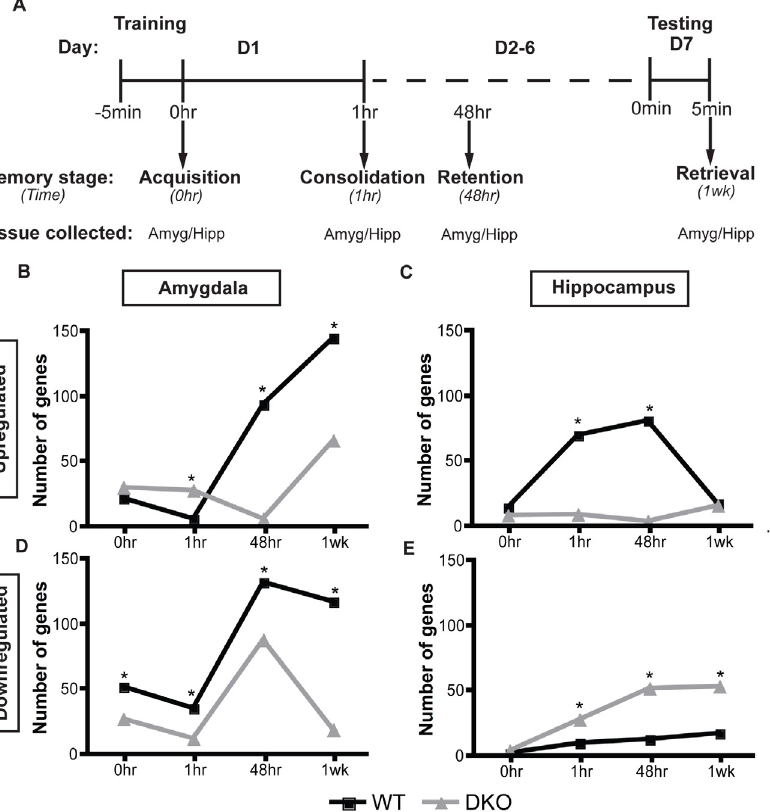
Figure 2. Microarray analysis setup and gene expression changes. ( A ) Amygdala and hippocampal micropunches were taken at baseline and four time points across CF learning (0 hr, 1 hr, 48 hr, 1 wk) in WT and DKO mice (1 array per genotype/brain region/time point). The number of genes showing a 6 1.5 fold change from baseline is graphed. ( B , D ) WT mice show the largest change in gene expression at the 48 hr and 1 wk time points in the amygdala and ( C , E ) at the 1 hr and 48 hr time points in the hippocampus. Overall, DKO mice show a suppression in gene expression changes, except at 1 hr in the amygdala when DKO mice show more gene changes that WT mice (* Chi-square, WT vs DKO p # 0.05).